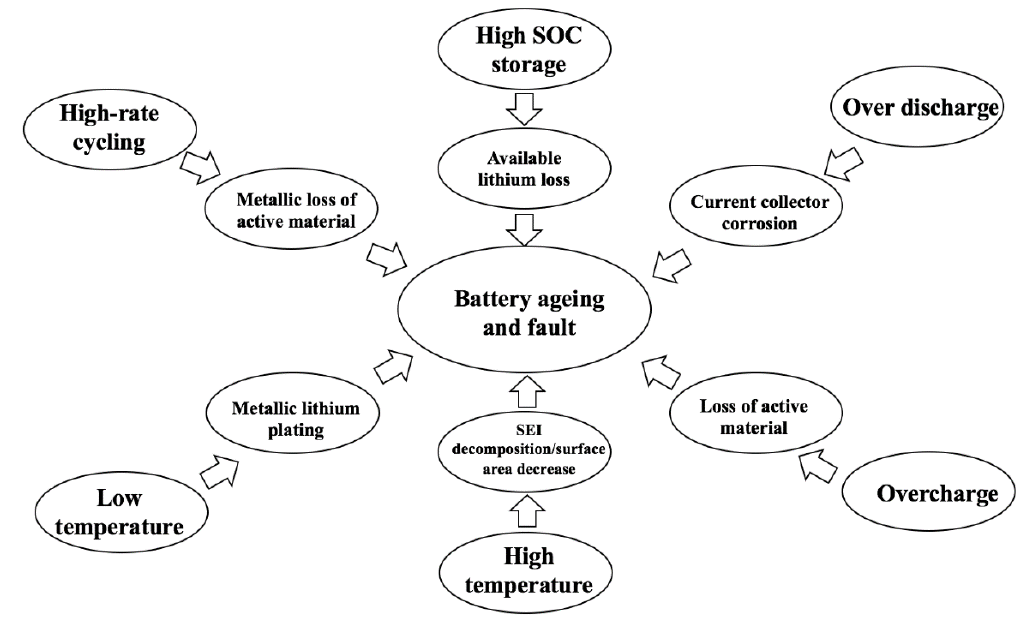
Figure 16. Analysis of the reasons for battery aging [139].